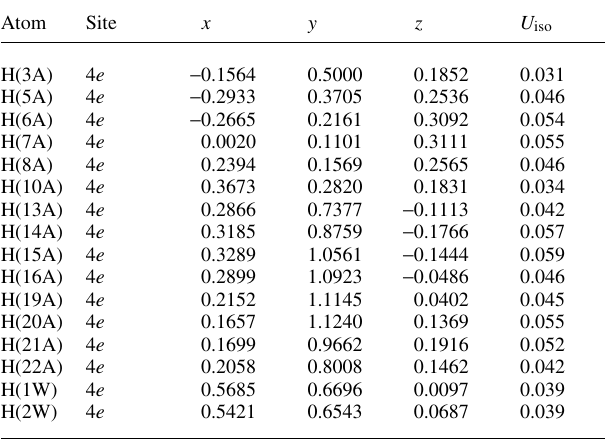
Table 2. Atomic coordinates and displacement parameters (in Å 2 )